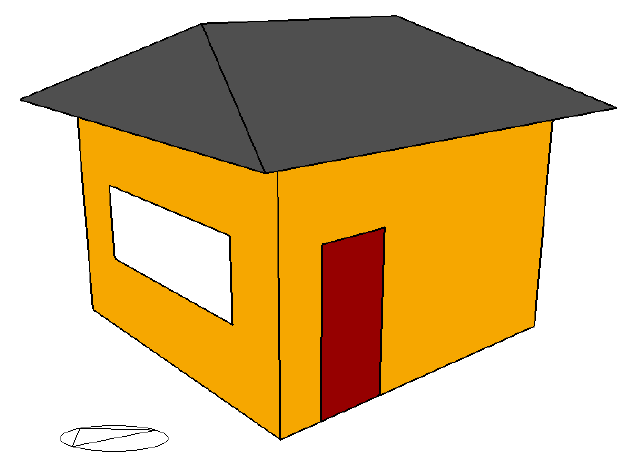
Figure 5. Single zone building model by adapted from Alam et al. [42].